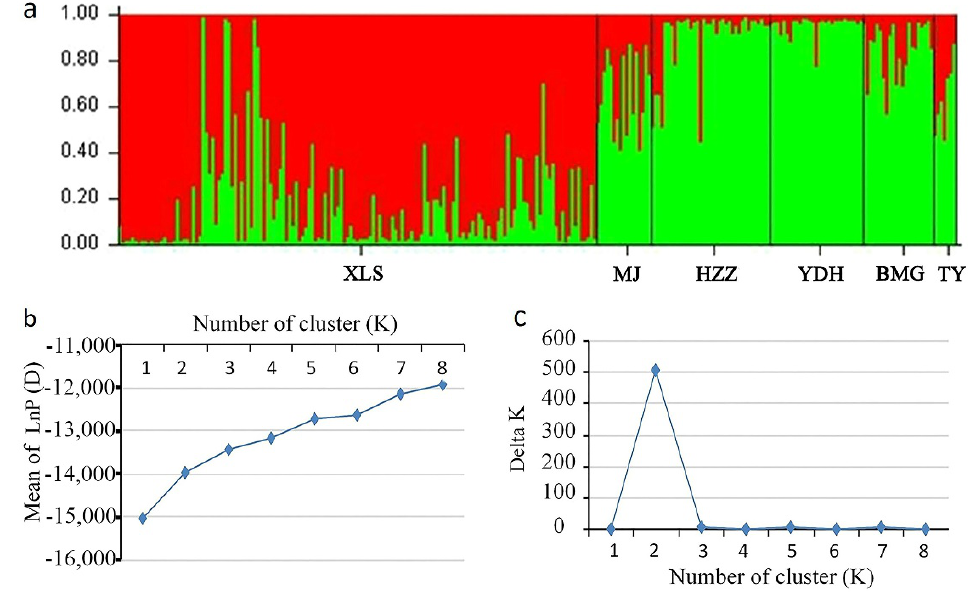
Figure 4. Population structure of 261 A. miaotaiense individuals based on 19 EST-SSRs markers. ( a ) Estimated genetic structure of the six populations based on STRUCTURE analysis; ( b ) Estimation of population using the mean of Ln P(D) based on ten repetitions for each K value; ( c ) plot of delta K (ΔK) for K ranging from 1 to 8.